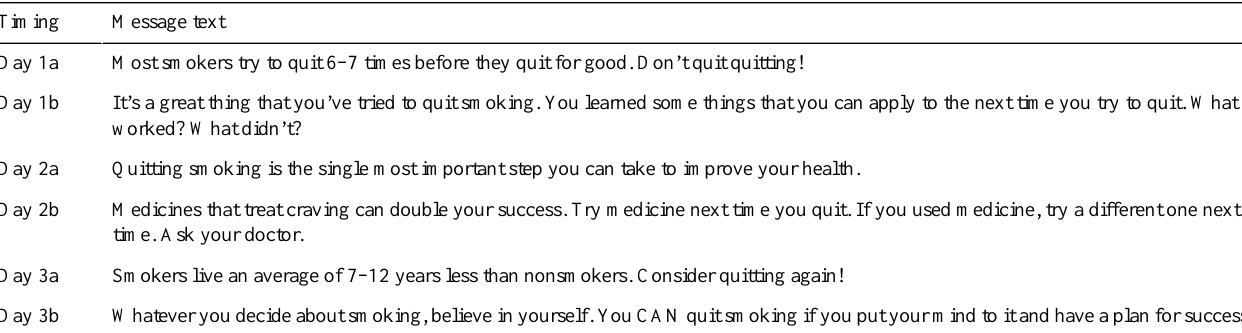
Table 3. Example of SMS Turkey content: the encouragement path. Message